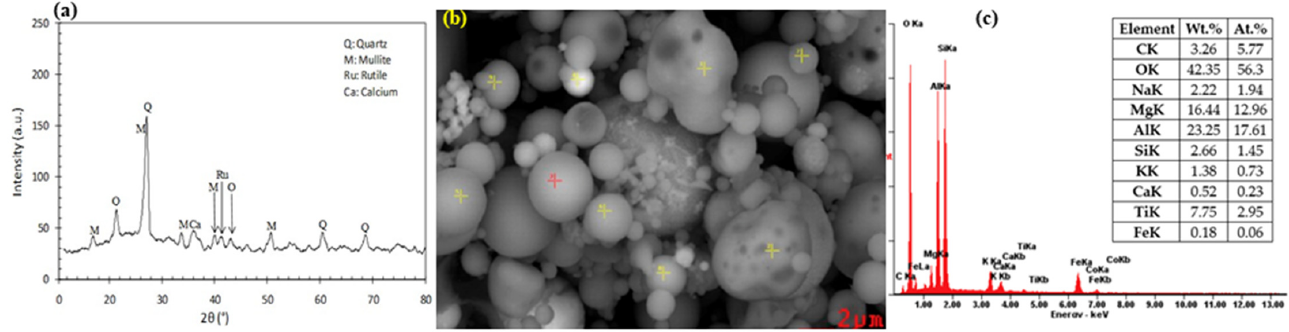
Figure 9. Typical XRD pattern ( a ), SEM picture ( b ), and EDX analysis ( c ) of the coal fly ash sam- Figure 9. TypicalXRDpattern( a ), SEMpicture( b ), andEDXanalysis( c